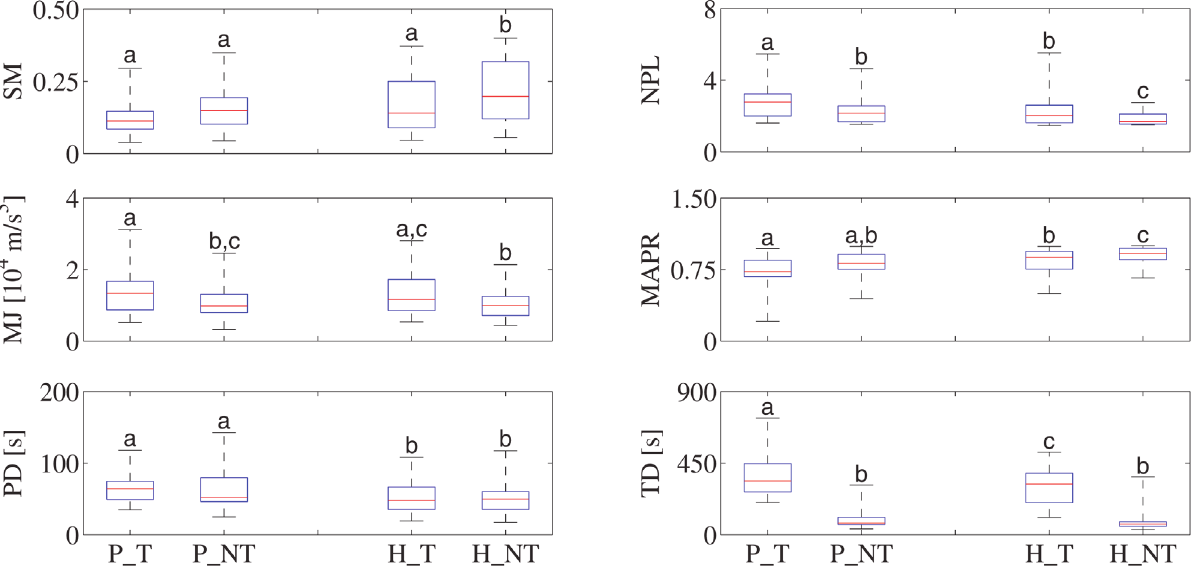
Fig 5. Speed metric (SM), normalized path length (NPL), mean of jerk (MJ), mean arrest period ratio (MAPR), path duration (PD), and task duration (TD) for both groups and both tasks, where P_T, P_NT, H_T, and H_NT denote respectively patients task T, patients task NT, healthy subjects task T, and healthy subjects task NT. Results are given as box plots, where the red line is the median, edges are the 25th and 75th percentiles, and whiskers extend to the extremes of the data. Whiskers not sharing a common letter are statistically different.